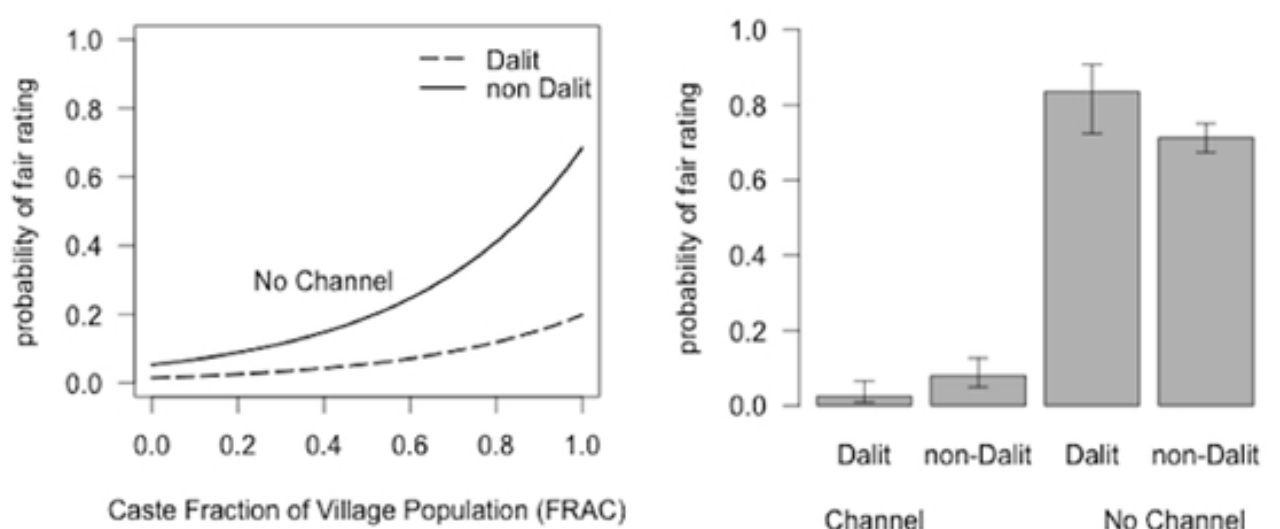
Fig. 2. Influences on perceived fairness. LEFT: the estimated probability of a fair rating given different relative sizes of the respondent’s caste within a village (FRAC). Probability estimates show that non-Dalit fairness perceptions climb faster than Dalit perceptions with increasing demographic strength. Estimates are for individuals with no channel access, because those with access reliably rated the irrigation system as very fair. RIGHT: the effects of Dalit status and channel access on perceptions of fairness in irrigation, 95% confidence intervals. The term Dalit refers to the servant groups also termed Harijan, untouchable, or Scheduled